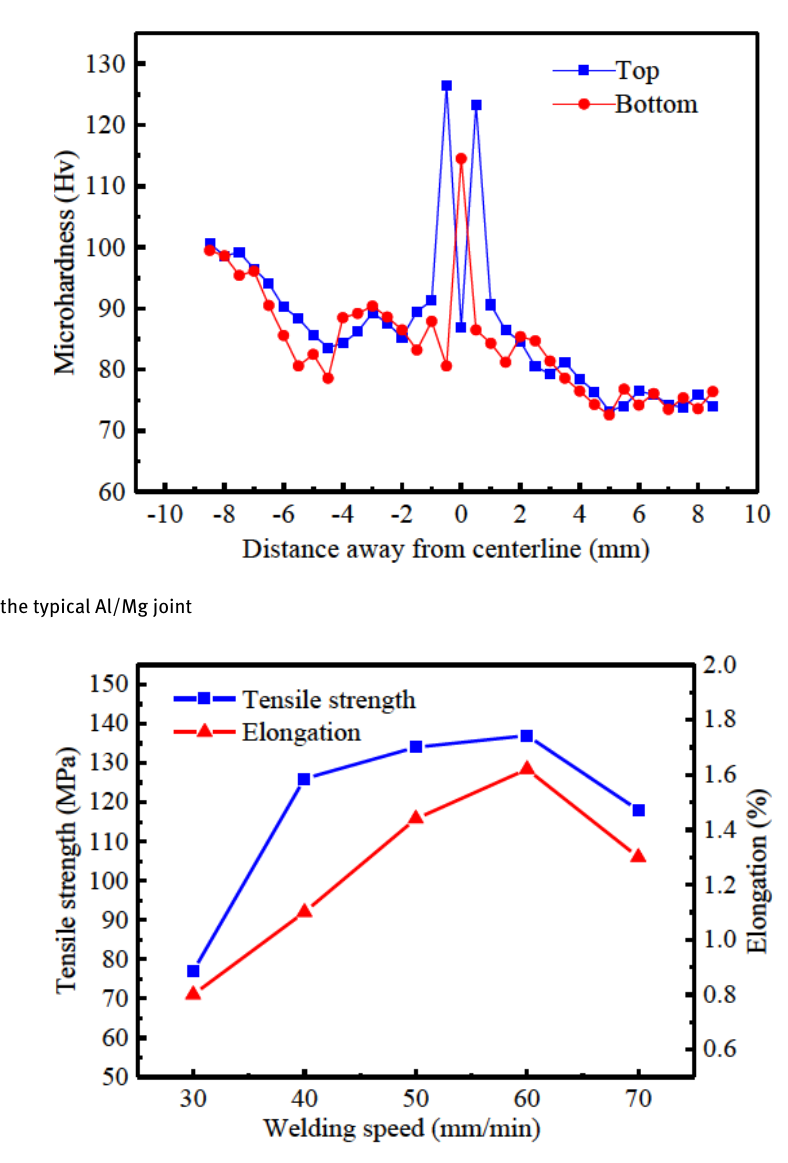
Figure 8: Tensile properties of the Al/Mg joints based on SSFSW